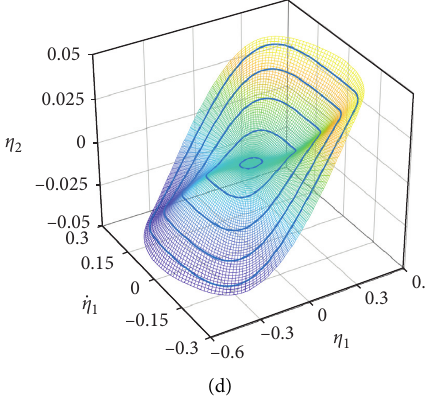
� 1 . 0, and the corresponding free periodic h 1 ( 􏽢 x , _ 􏽢 x ) and η ( η , _ η ) , respectively; the 2 1 1 2 1 1 ( η , _ η ) is the projection of 􏽢 x ( 􏽢 x , _ 􏽢 x ) onto the phase 2 1 1 2 1 1